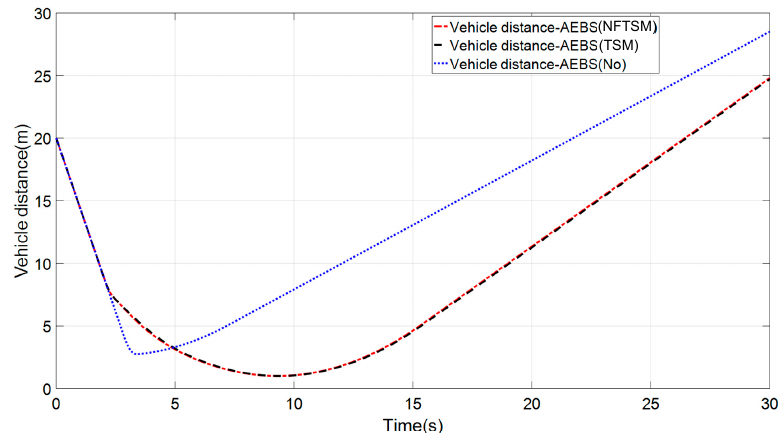
Figure 18. Comparison of relative distance.